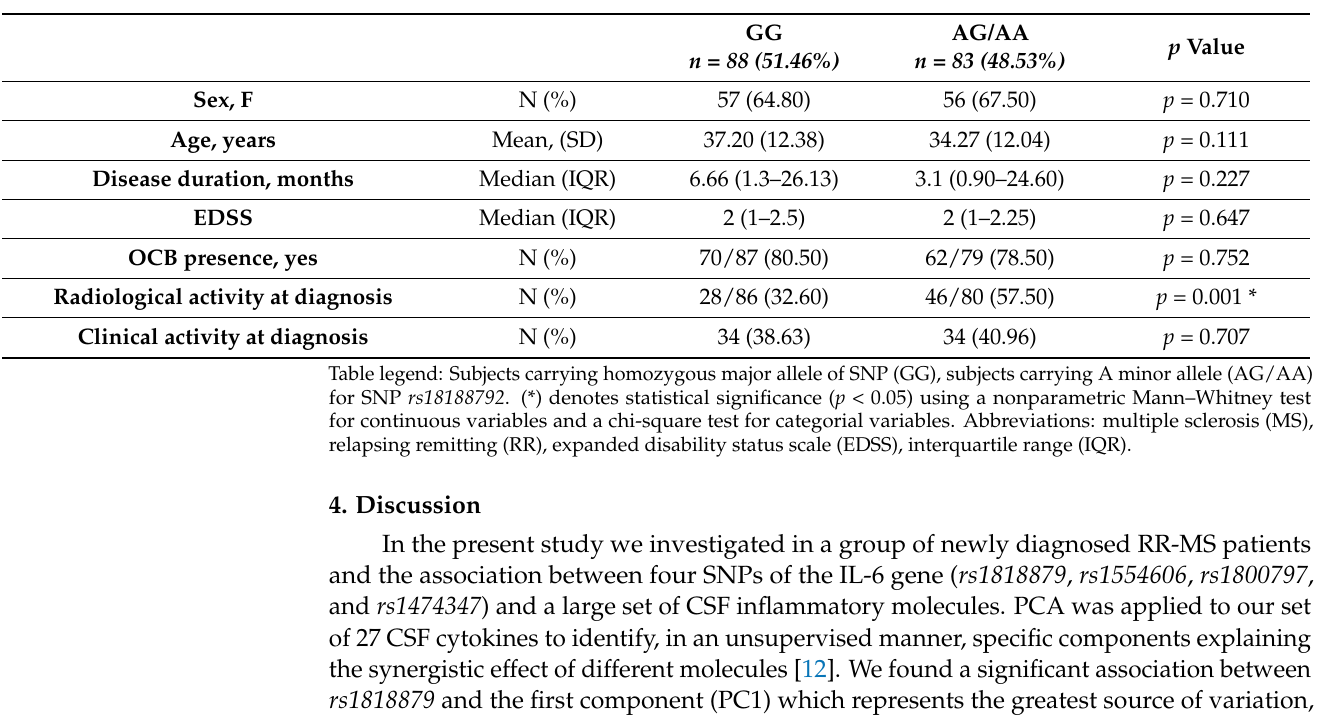
Table 4. Demographic and clinical characteristics of RR-MS patients according to the SNP rs1818879 group.